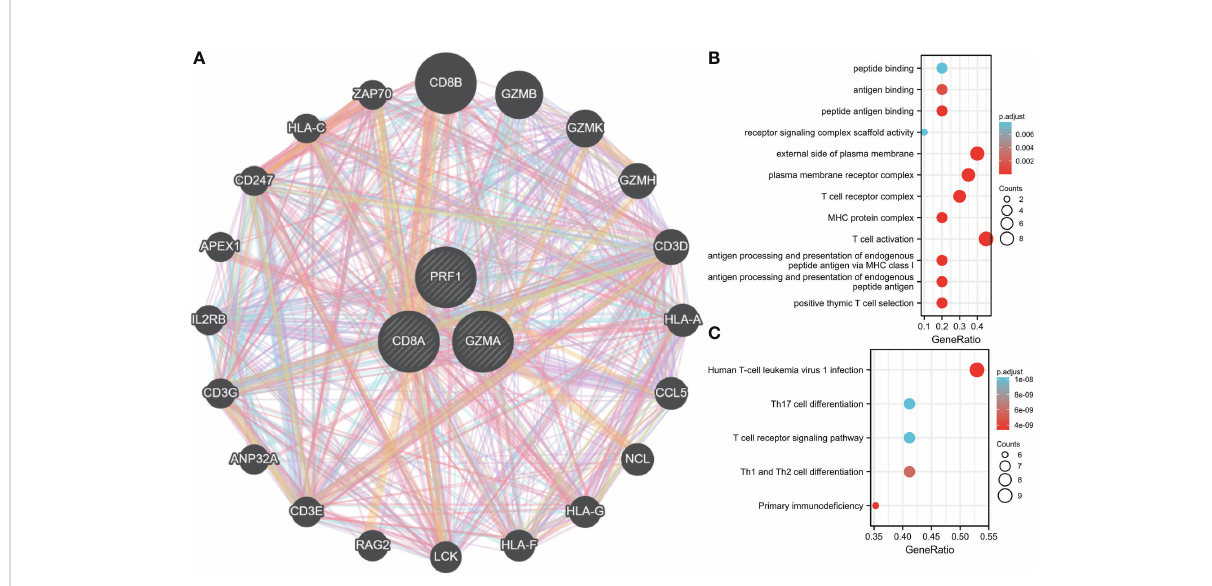
FIGURE 10 Interaction analysis of Hub genes. (A) Characterized gene co-expression network. (B) GO analysis of co-expressed genes. (C) Co – expressed gene KEGG